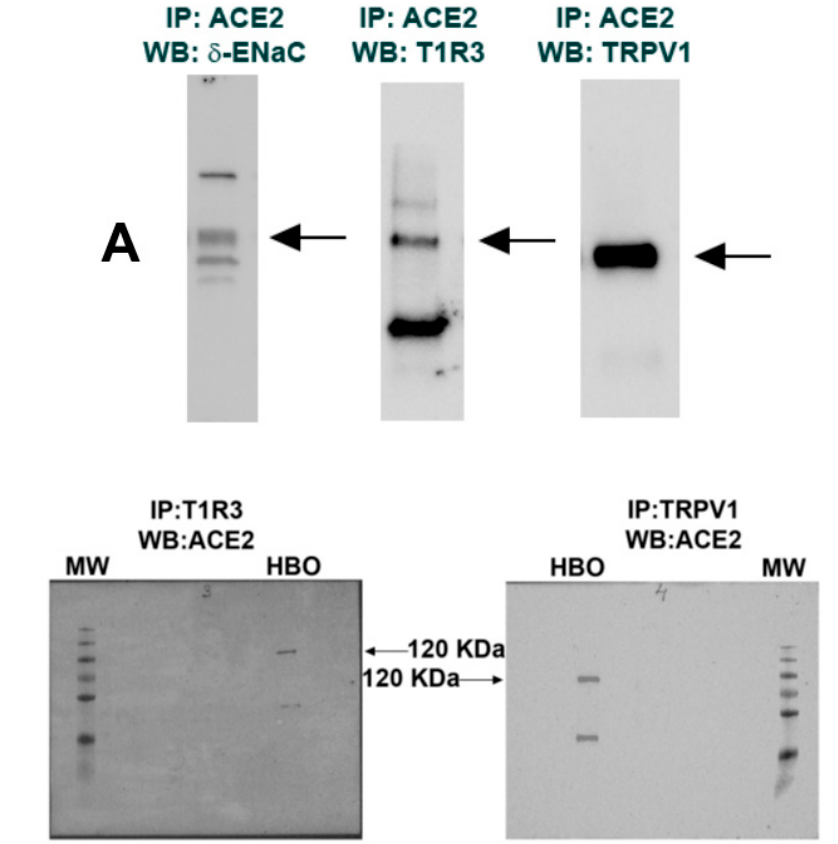
Figure 4. Interactions among ACE2, δ -ENaC, T1R3, and TRPV1: ( A ) co-immuno-precipitation of ACE2/ δ -ENaC, ACE2/T1R3, and ACE2/TRPV1; ( B ) co-immuno-precipitation of T1R3/ACE2 and TRPV1/ACE2. Molecular weight (MW) protein ladder bands correspond to 10–250 KDa (bottom to top).